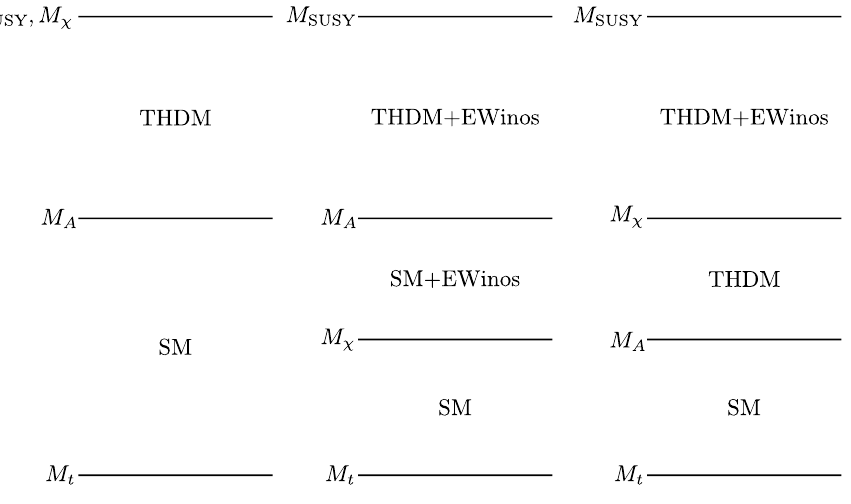
Figure 1 . EFT towers covered in this work (gluino threshold not